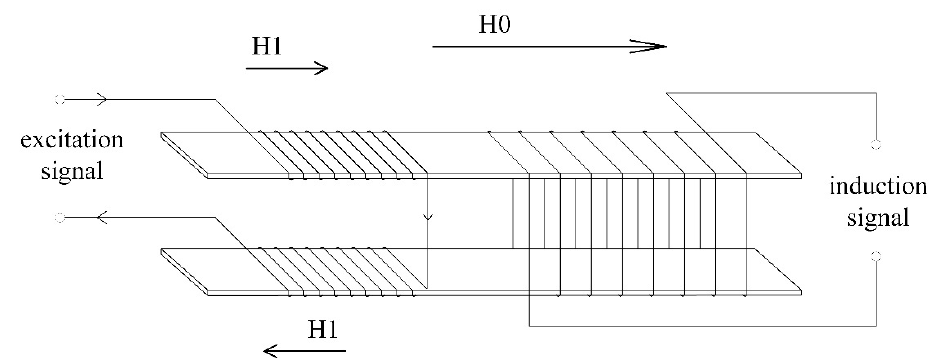
Figure 1. A dual-core fluxgate probe structure.